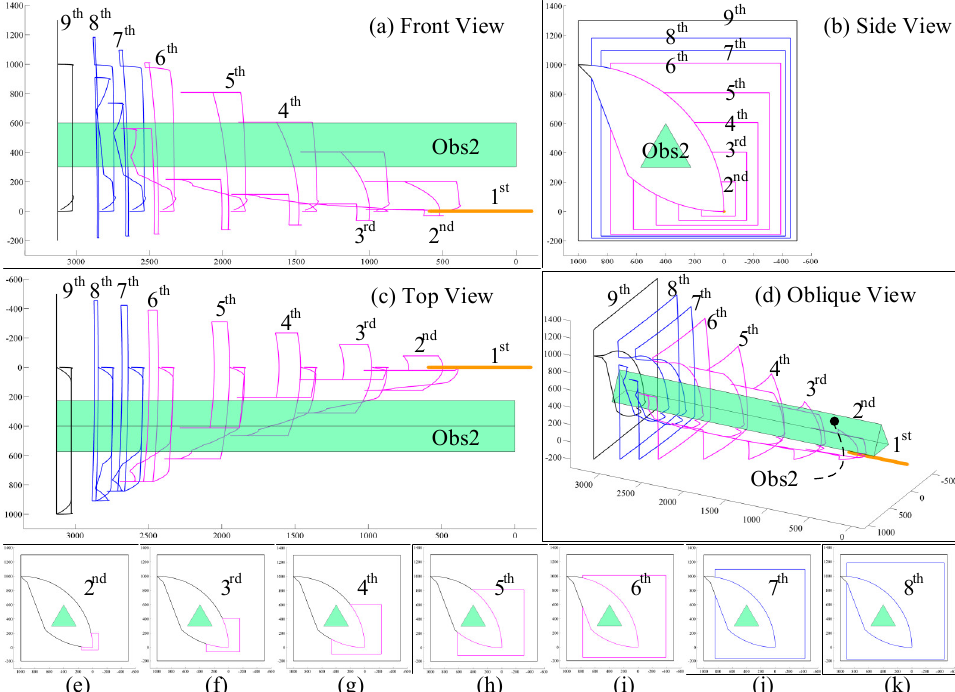
Figure 12. Motion paths of 9 key points in obs2. ( a ) Front view; ( b ) Side view; ( c ) Top view; ( d ) Oblique view; ( e ) Motion projection of 2nd joint; ( f ) Motion projection of 3rd joint; ( g ) Motion projection of 4th joint; ( h ) Motion projection of 5th joint; ( i ) Motion projection of 6th joint; ( j ) Motion projection of 7th joint; ( k ) Motion projection of 8th joint.